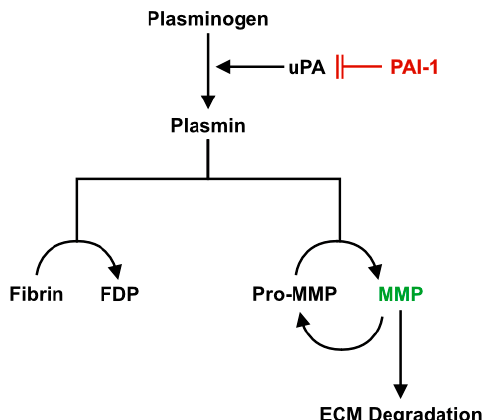
Figure 1. Plasminogen system. Plasminogen is the inactive substrate of the plasminogen system that is activated into plasmin primarily by urokinase plasminogen activator (uPA) in skeletal muscle. Plasmin can directly degrade fibrin into fibrin degradation products (FDPs) and activate MMPs. The MMPs work to degrade connective tissue in the ECM and also activate additional MMPs in a positive feedback loop. PAI-1 functions as the upstream inhibitor of the plasminogen system by inhibiting uPA and thus preventing the activation of plasminogen. Adapted from Higazi, A.A.-R